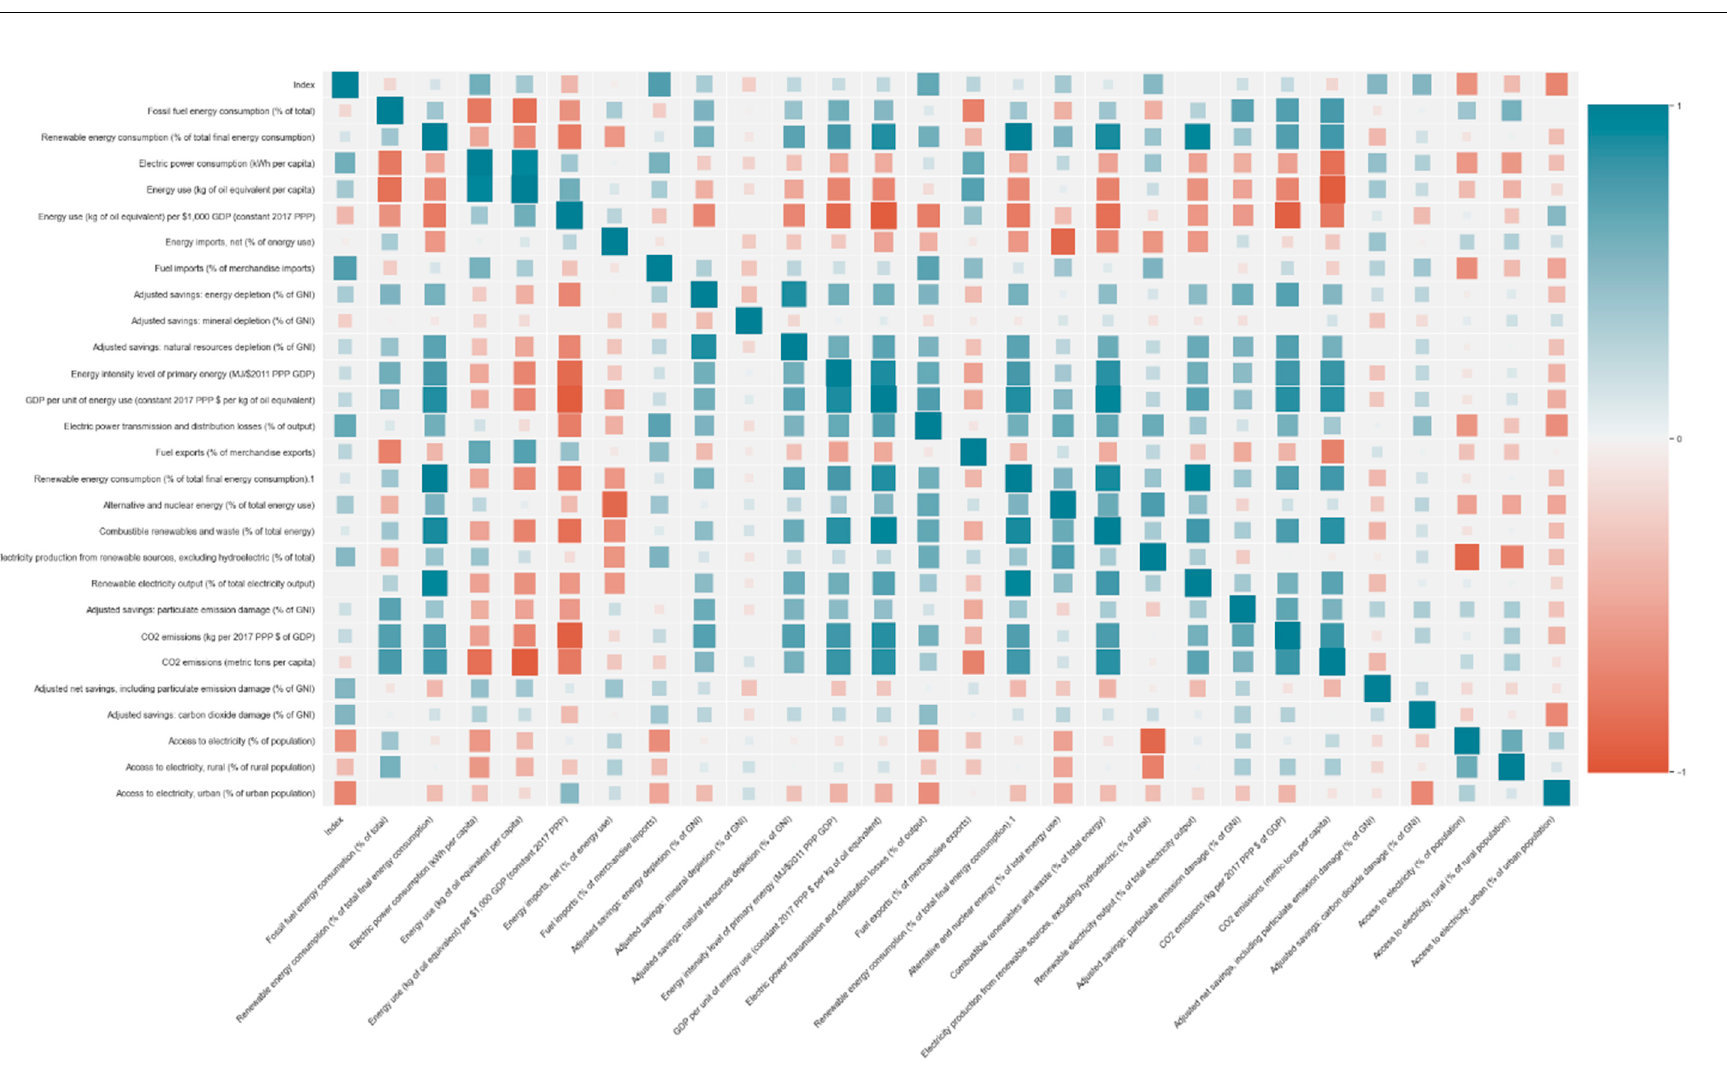
Figure 13. Correlation matrix: between factors (Python representation).